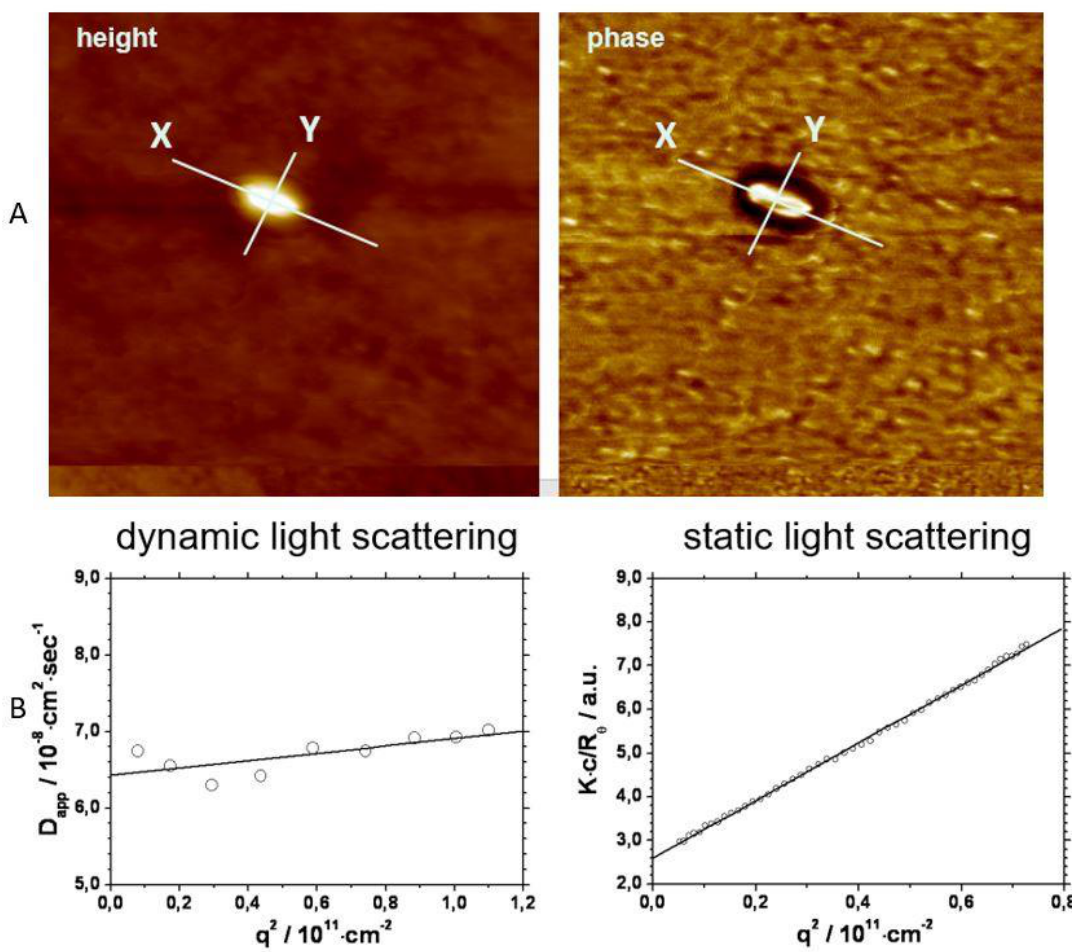
Figure 4. Visualization ( A : upper line, AFM) and characterization by light scattering ( B : lower line) of properly coated, individually dispersed inorganic nanoparticles (see [39] for more information); reproduced with permission of the ACS [39], published by the ACS, 2008.